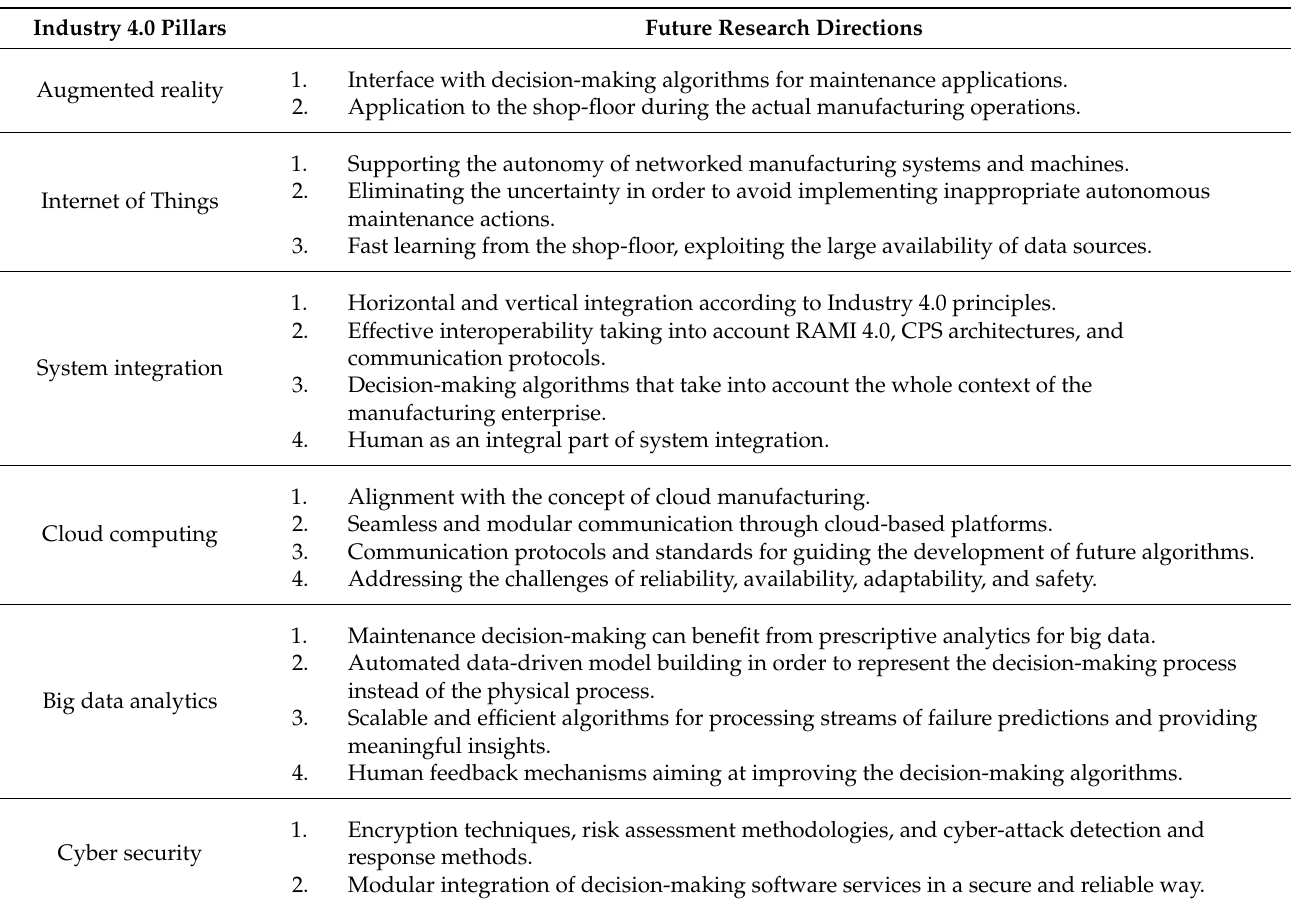
Figure 4. The nine pillars of Industry 4.0. Table 11. Research agenda of decision-making for Industry 4.0 maintenance